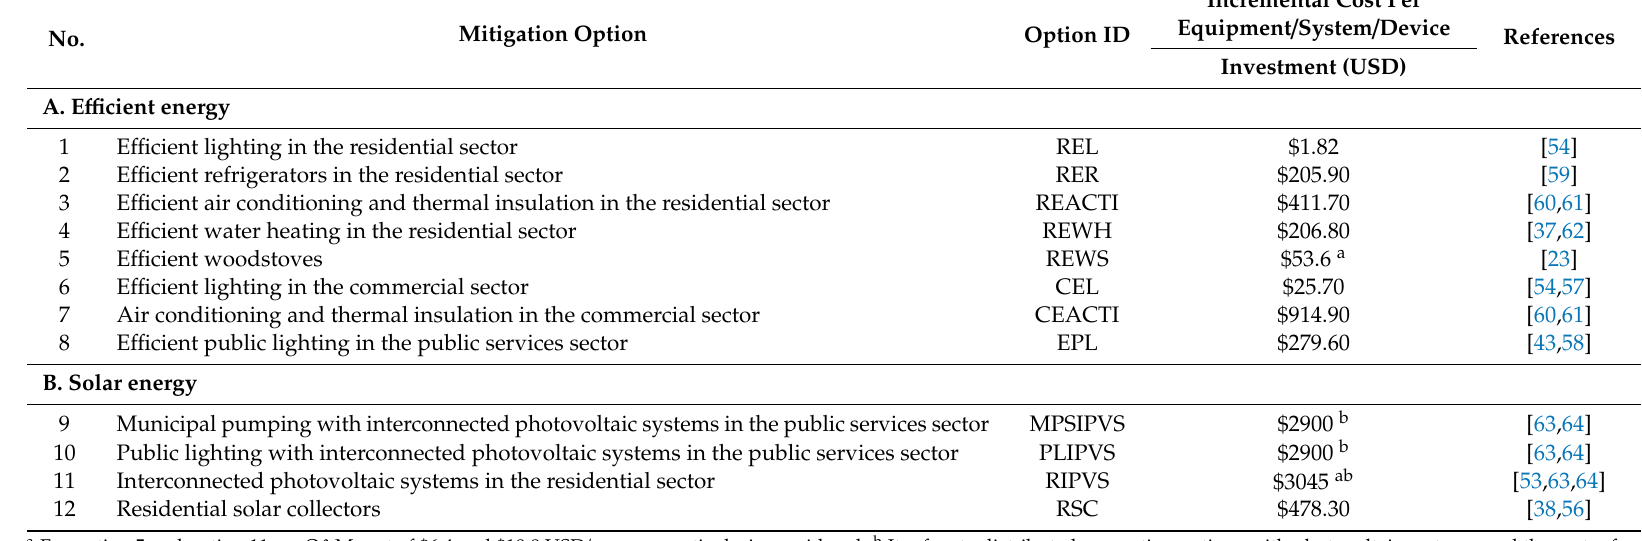
Table 4. Incremental costs of the EE and SE options in the mitigation